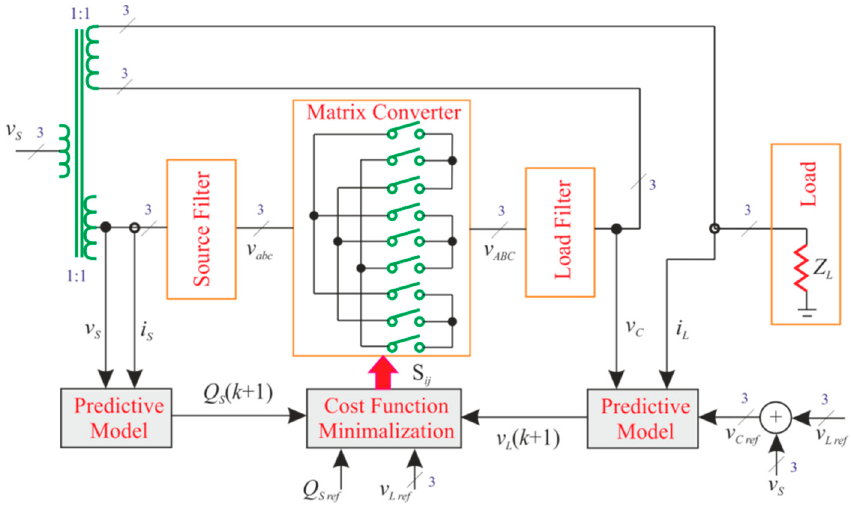
Figure 18. MPC of an HT voltage compensator with an MC and minimalization of the output voltage tracking error and input power factor.